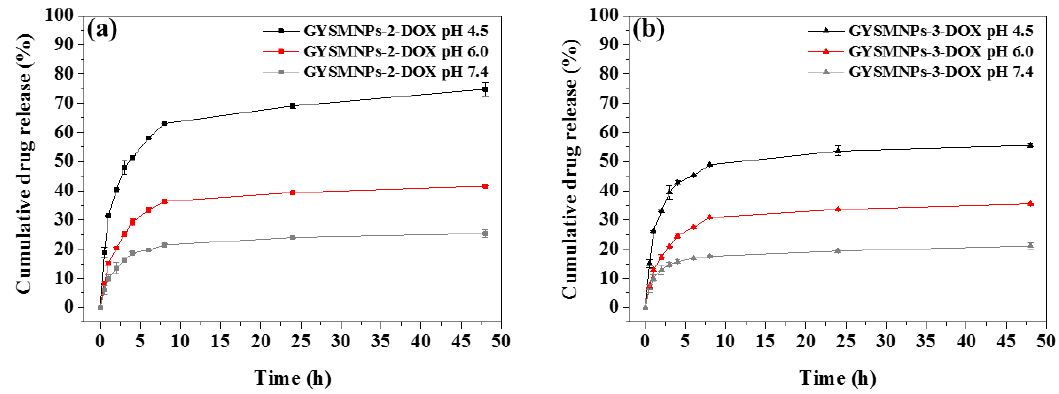
Figure 6. The pH-responsive release profiles of doxorubicin (DOX) from GbMNPs under different pH values (7.4, 6.0, and 4.5), at 37 °C. ( a ) GbMNP-2-DOX; ( b ) GbMNP-3-DOX. Error bars represent the standard deviation of triplicate drug release tests.